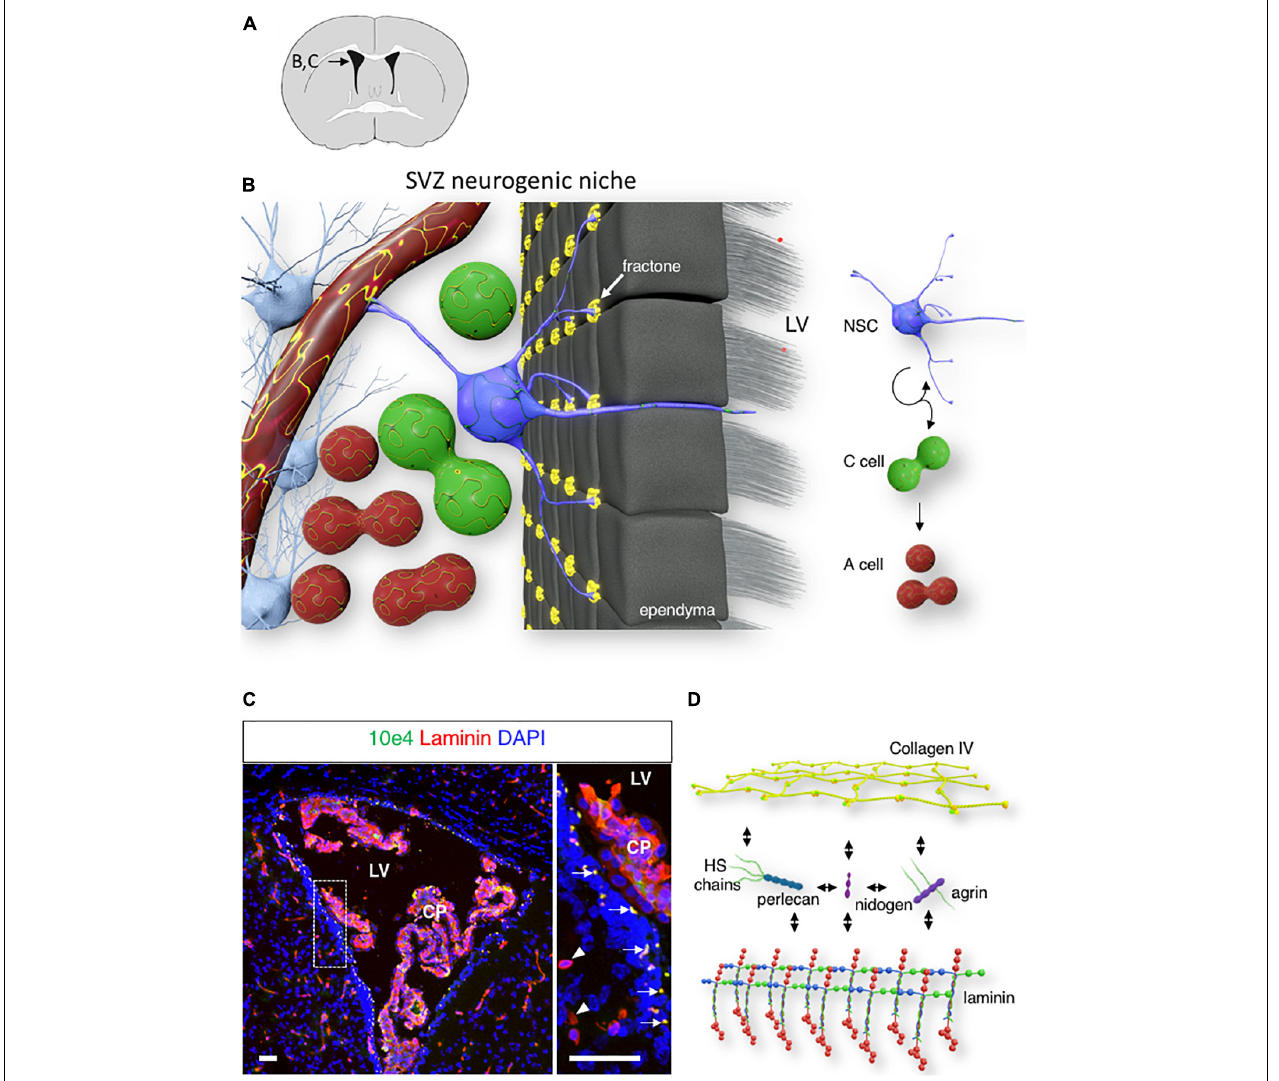
FIGURE 1 | Fractone: extracellular matrix (ECM) niche in the SVZ. (A) A schematic of a mouse brain coronal section at bregma 0.1 mm, with an inset displaying the localization of the lateral ventricle shown in panels (B,C) . (B) 3D rendering of the SVZ neurogenic niche showing a single NSC (blue) contacting the ventricle lumen, a capillary, and numerous fractones (yellow). (C) Confocal image of the lateral ventricle displaying laminin (red) and N-Sulfated HS epitope 10E4 (green) immunoreactivity in the SVZ. Arrows indicate the fractones that are immunoreactive for both laminin and N-sulfated HS epitope 10E4. Arrowheads indicate laminin-immunoreactive SVZ capillaries. Scale bar: 50 µ m. (D) A schematic of major fractones ECM